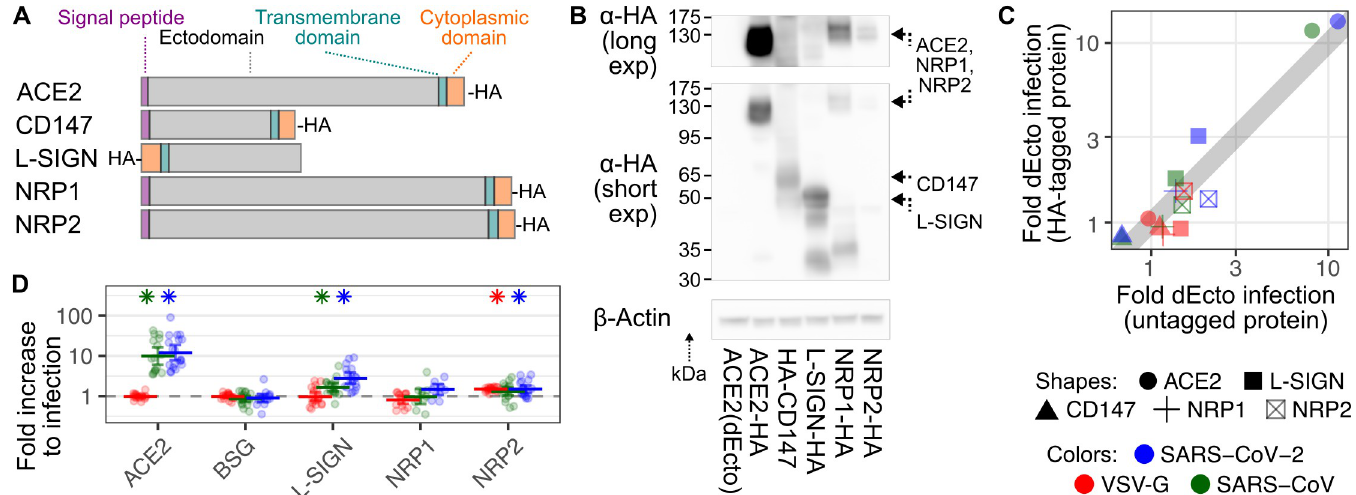
Fig 2. Established and proposed SARS-CoV-2 receptor proteins. (A) Schematic showing relative lengths, tag locations, and overall domain topologies of proteins. (B) Representative immunoblot of cells stably expressing HA-tagged versions of each protein, including longer (top) and shorter (bottom) anti-HA exposures. Beta actin was blotted as a loading control. (C) Scatter plot comparing normalized pseudovirus infection rates of cells stably expressing various HA-tagged and untagged proteins. Shapes correspond to receptors. Colors correspond to viruses. (D) Compiled normalized infection data for the established and proposed SARS-CoV-2 receptor proteins. Error bars denote 95% confidence intervals for at least 10 replicates. Asterisks denote samples with p < 0.01. The underlying data can be found in S2 Data, and the source code can be found at https://github.com/MatreyekLab/ACE2_dependence. ACE2, angiotensin converting enzyme-2; SARS-CoV, Severe Acute Respiratory Syndrome- related Coronavirus; SARS-CoV-2, Severe Acute Respiratory Syndrome-related Coronavirus 2; VSV-G, vesicular stomatitis virus glycoprotein.